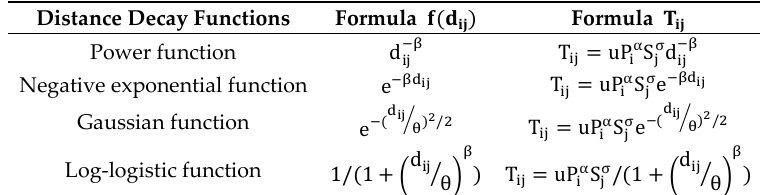
Table 1. Distance-decay functions and the corresponding gravity models.